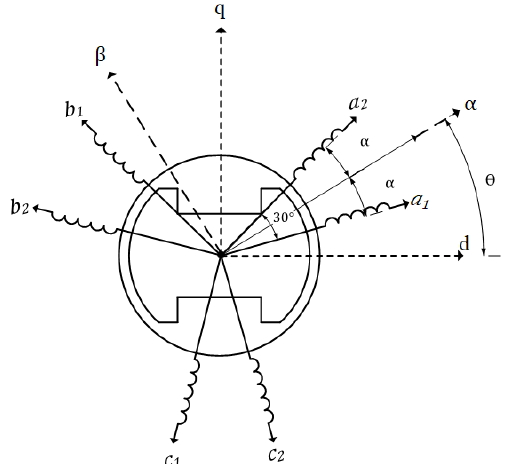
Figure 7. Reference frame configuration for decoupled transformation.